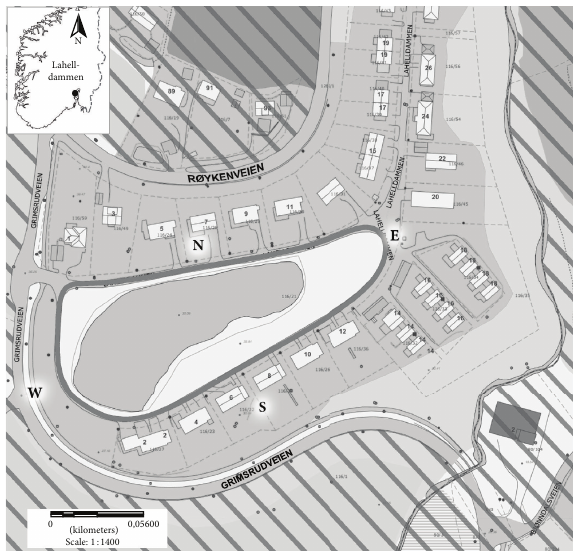
Figure 1: Map of the pond Lahelldammen (UTM WGS84 33N 0236699 33S 6630232) in southeastern Norway with the route for observation (Lahelldammen road, black line) and areas which are difficult to access are